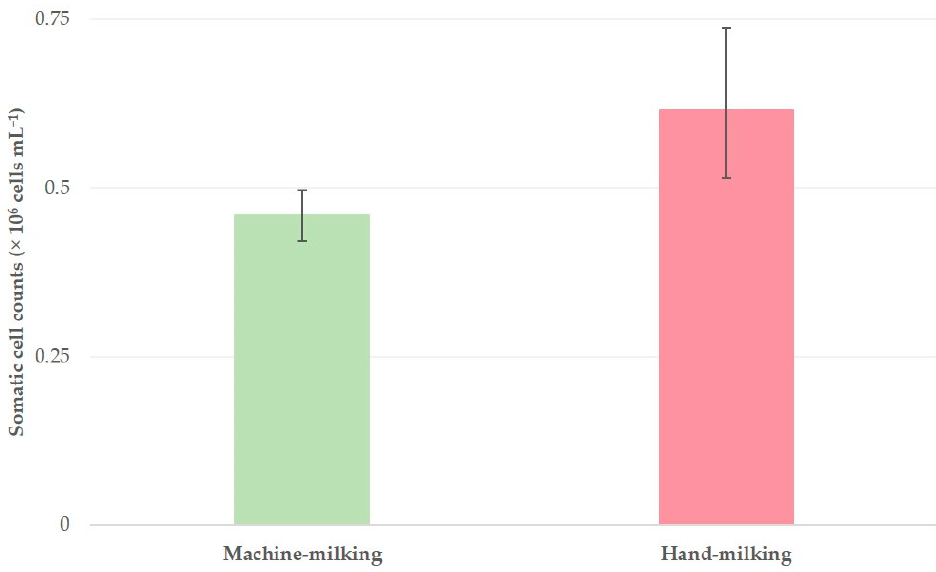
Figure 5. Geometric mean somatic cell counts in the bulk-tank milk of 325 sheep flocks in Greece, in accord with the milking mode practiced in the flocks (bars indicate 95% confidence intervals of the geometric mean). Table 5. Results of multivariable analysis for increased somatic cell counts (> 1.0 × 10 6 cells mL − 1 ) in the bulk-tank milk of 325 sheep flocks in Greece (mixed effects logistic regression).